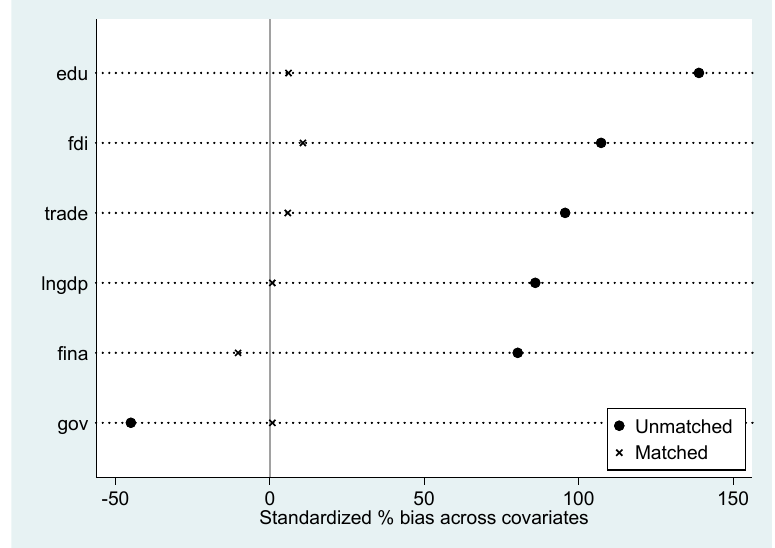
Figure 3. Propensity score matching effect. The solid red line in Figure 4 indicates the kernel density curve of the estimated coefficients of the core explanatory coefficients of the 1000 pseudo-regressions; the blue hollow circles are the p -values of the 1000 pseudo-regressions; and the red dashed line at the level of the horizontal axis indicates p = 0.1. Based on this, it is obvious from Figure 4 that, first, the estimated coefficients of the core explanatory variables of the 1000 pseudo- regressions are all clustered around the value of 0, and second, the majority of p -values are distributed above the dashed line at p = 0.1. The above results indicate that the carbon emission of BC is indeed brought about by real policies rather than by other time-varying factors.